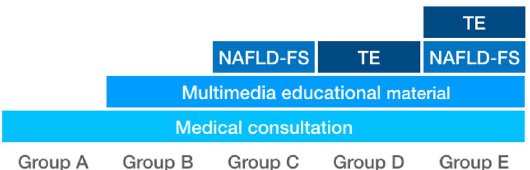
Figure 1. Interventions received per group. Non alcoholic fatty liver disease fibrosis score (NAFLD-FS), transient elastography